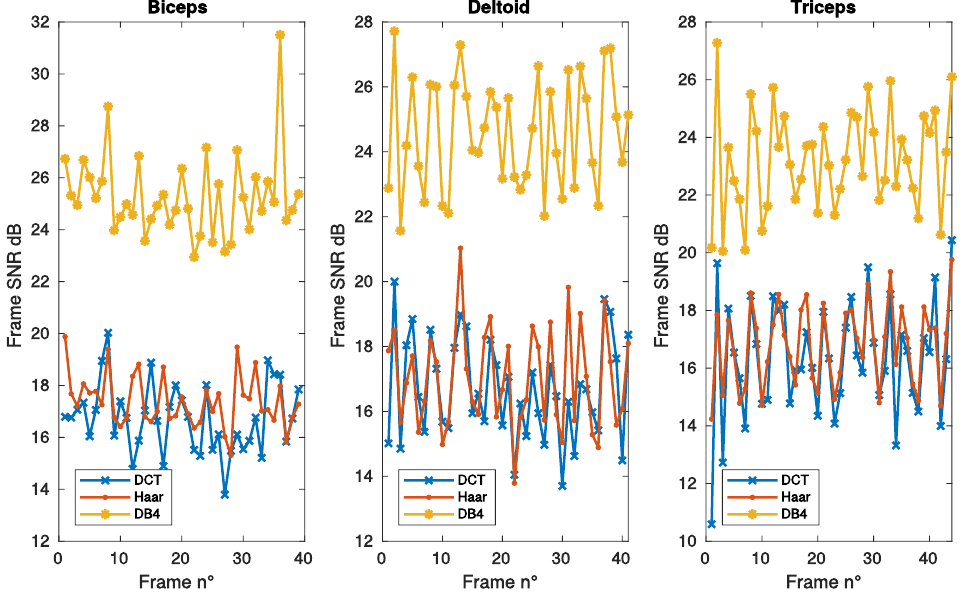
Figure 2. SNR vs. frame number, as achieved with convex optimization, using DCT, Haar, and DB4 bases, for the same muscles of Figure 1.